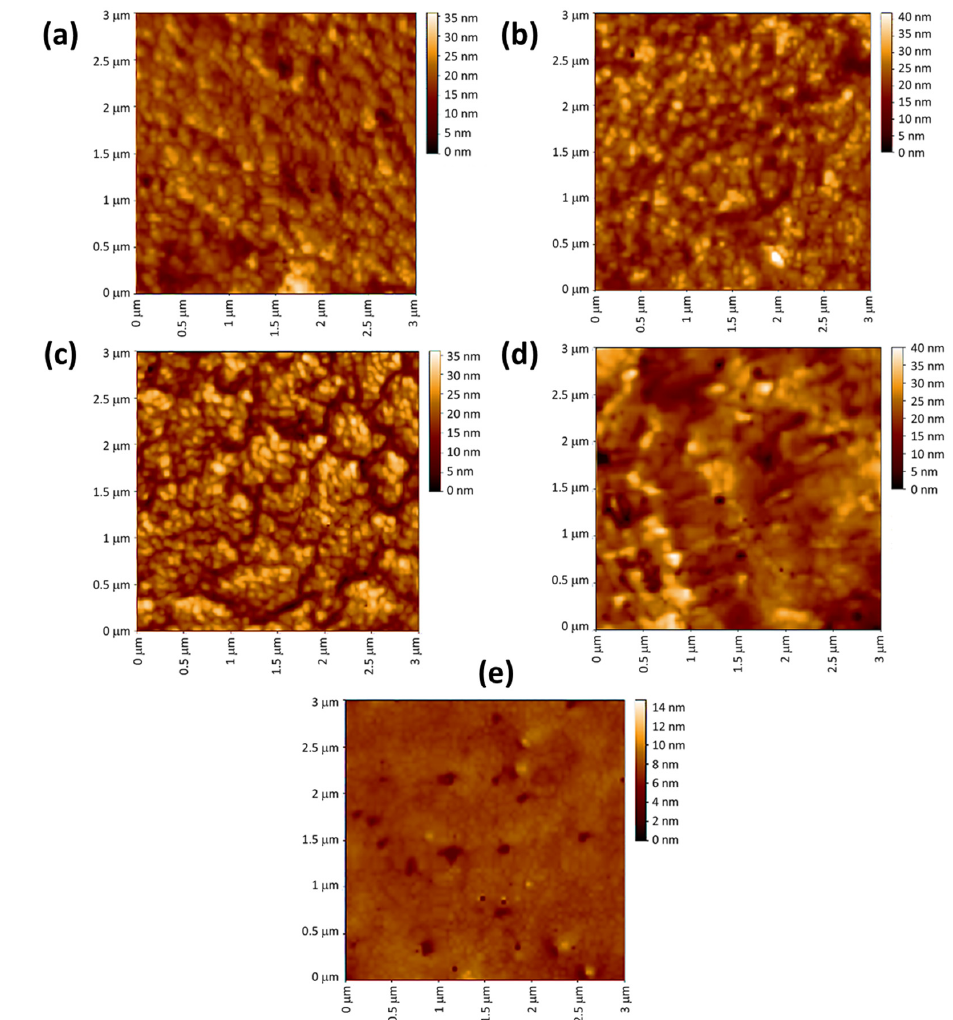
Figure 11. AFM image of ( a ): PVC/L/Ti NPs, ( b ): PVC/L/Cu NPs, ( c ): PVC/L/Co NPs, ( d ): PVC/L/Cr NPs, and ( e ): PVC/L/Ni NPs after irradiation (300 h).